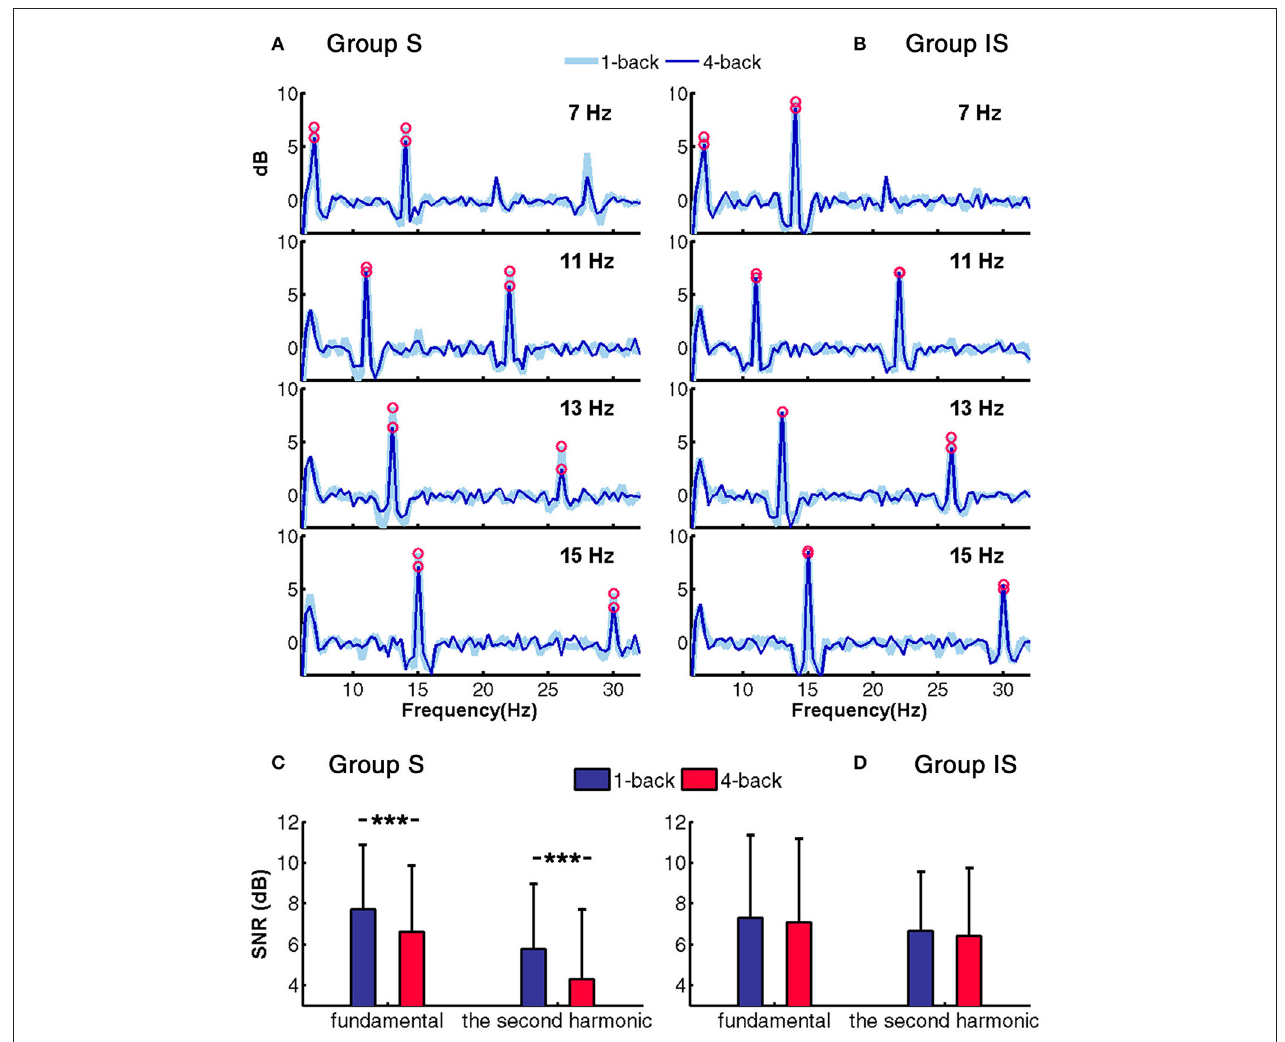
FIGURE 5 | SNR of SSVEPs on the Oz channel for the 1- and 4-back tasks. The red circles indicate the SNRs of the fundamental and second harmonic frequencies for each target SSVEP. (A) Group S. (B) Group IS. Mean SNR of all fundamental and second harmonics. The error bars represent the standard deviations across subjects and frequencies and asterisks represent significant differences between two n-back tasks (*** p < 0.001). (C) Group S. (D) Group